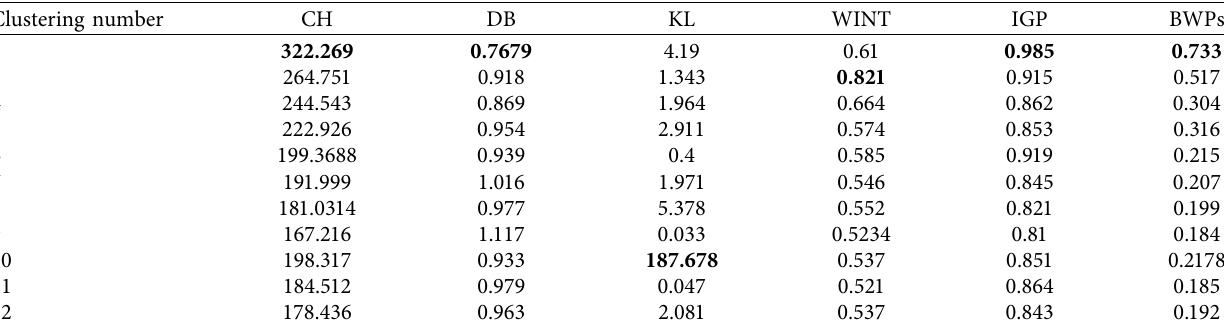
Table 2: Clustering validity index values of the BUPA dataset